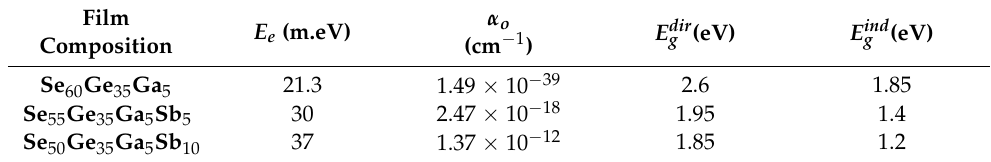
Table 3. The determined values of E e , α o . E dir g , E ind